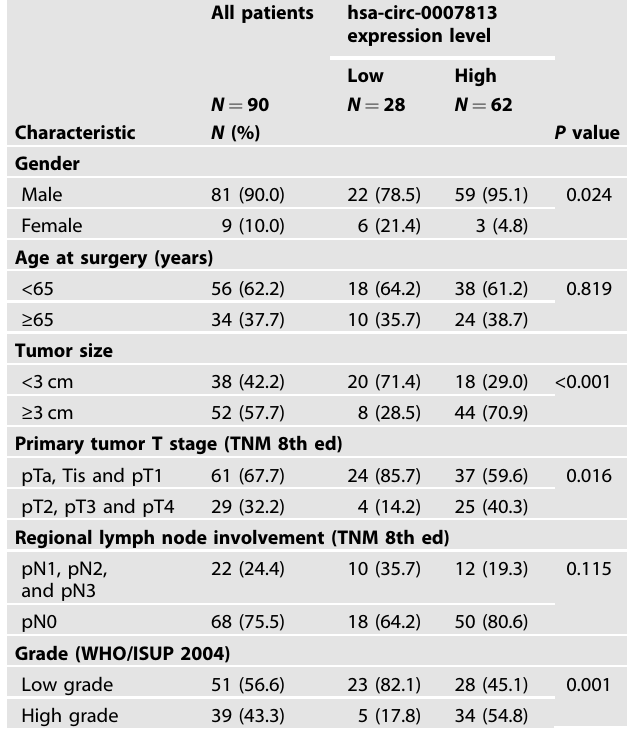
Table 1. Associations of hsa-circ-0007813 expression level with clinical and pathologic features for 90 bladder cancer